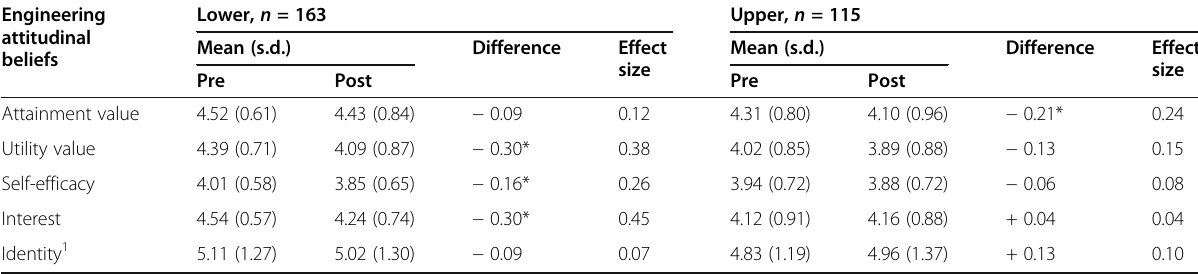
Table 4 Effects of time for lower and upper division students from RMANOVAs Engineering attitudinal beliefs